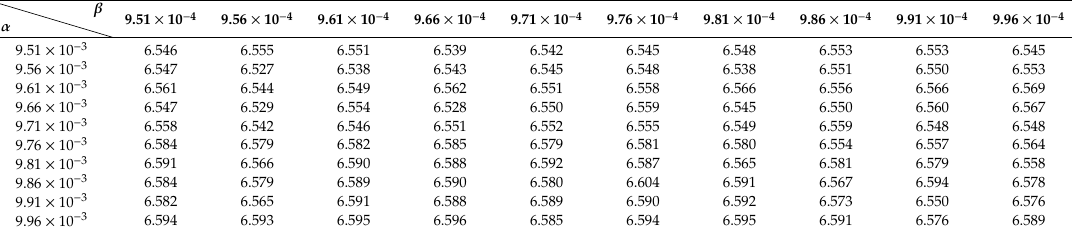
Table 8. Bottlenose Dolphin with di ff erent α , β corresponding to SNR data. β 9.51 × 10 − α